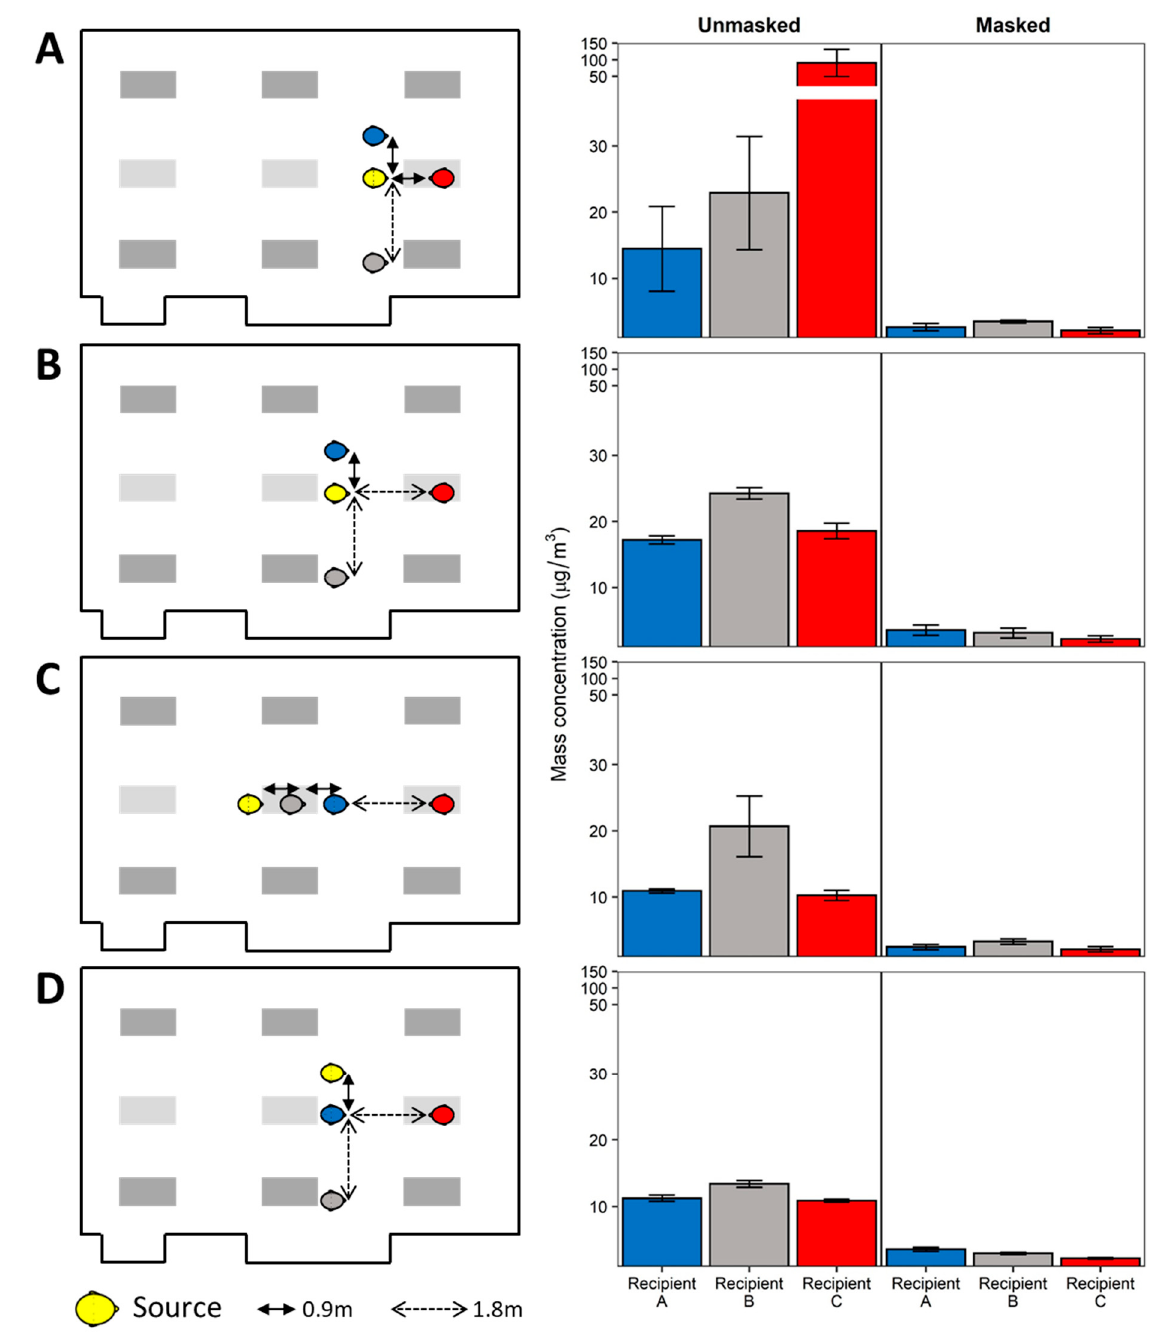
Figure 2. Participant aerosol source scenarios. The aerosol Source and Recipient breathing simulators were positioned in four placement configurations and the HVAC system ventilation was set to 4 ACH. The Recipient and Source simulators were positioned in ( A ) front row, ( B ) second row, ( C ) linear, and ( D ) second row source leftmost orientations. Mean mass concentrations measured at the Recipient breathing simulators for unmasked and universal masking experiments are shown. Data are presented as the mean of four independent experiments. Error bars represent one standard deviation.